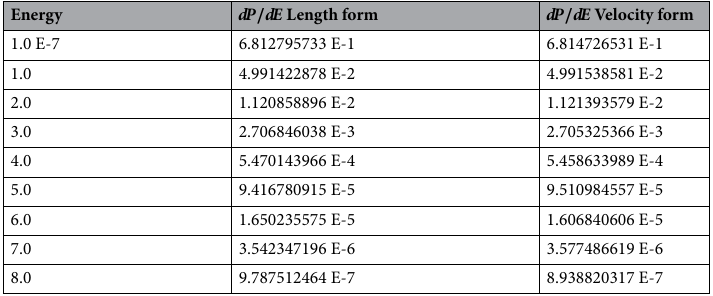
Table 1. Angle integrated ionization probabilities dP / dE for specific energies, either calculated with length or velocity form of the dipole operator. Column 1: energy of the emitted electron, column 2: dP / dE calculated in length form, column 3: in velocity form. The elctrical pulse is specified through E ( t ) = E 0 sin (ω t ) , = π = 1, ω = 2 and a duration T = 2 π E 0 ω